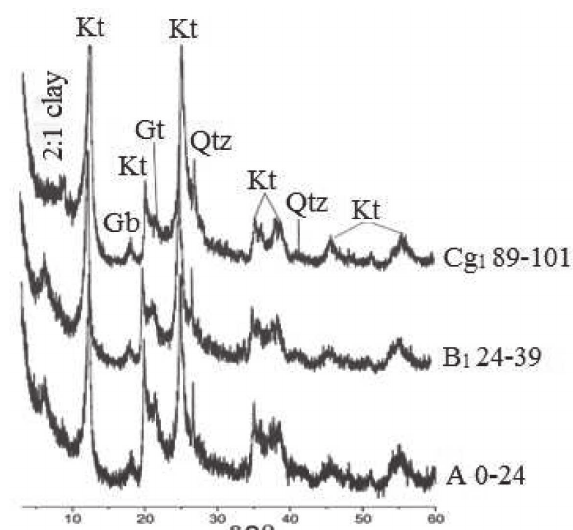
Figure 4. X-ray diffractogram of clay fraction of the A, B 1 and the Cg 1 horizons of the poorly drained P4: Kt, Kaolinite; Gb, Gibbsite; Gt, Goethite; Qtz, Quartz, and 2:1 clay mineral.